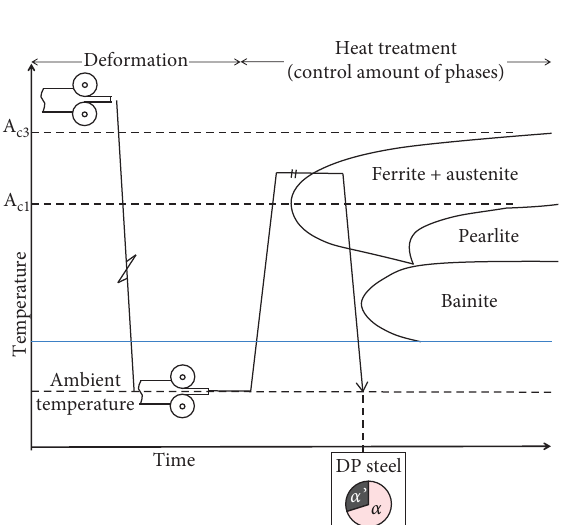
Figure 1: Dilatation of the steel for determining A